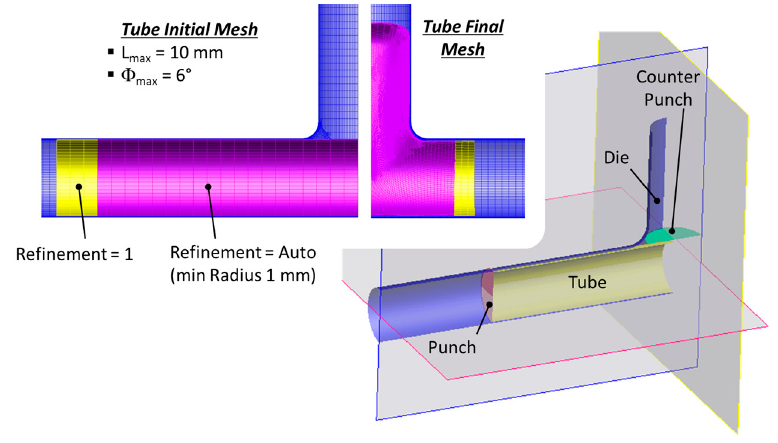
Figure 2. Finite Element Model (FEM) and tube meshing strategy.